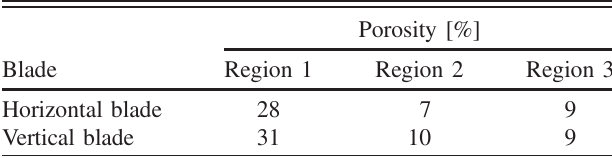
TABLE V. Estimated porosity of the tested blades following the endurance test [19] as measured in the three regions shown in Fig. 10, right